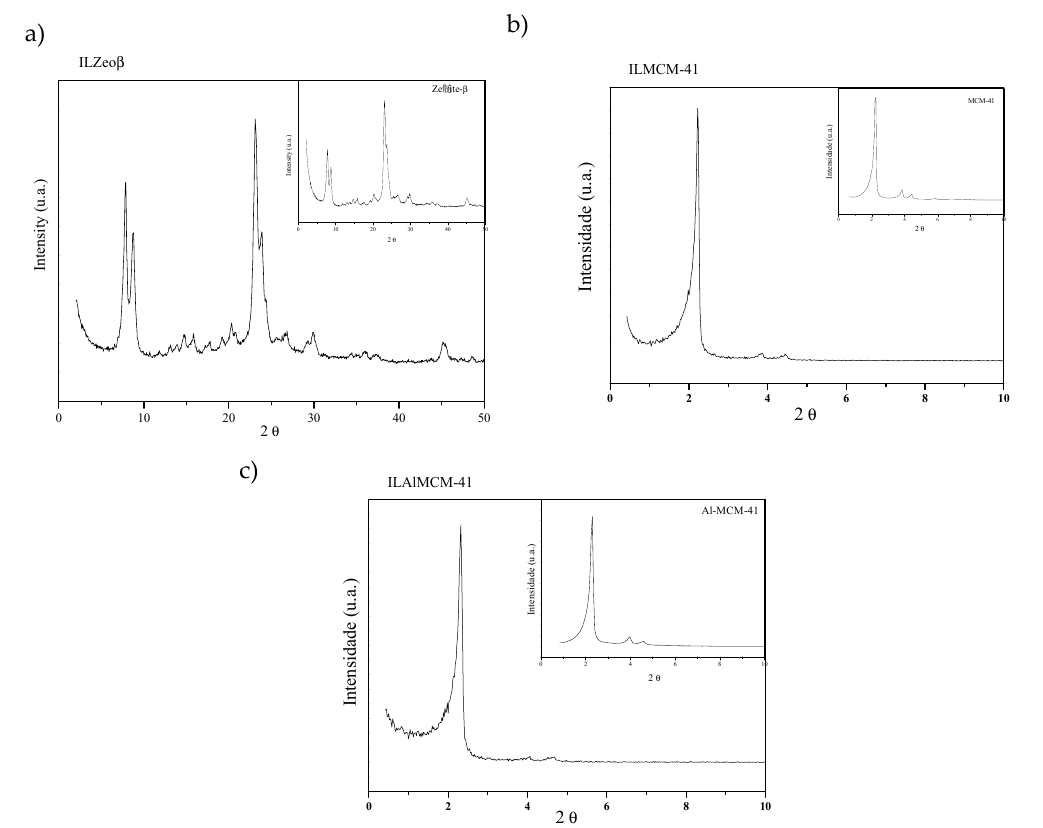
Figure 3. X-ray diffractograms of the ( a ) β -zeolite and IL-Zeo β ; ( b ) MCM-41 (Mobil Composition of Matter 41) and IL-MCM-41; and ( c ) Al-MCM-41 and IL-Al-MCM-41.